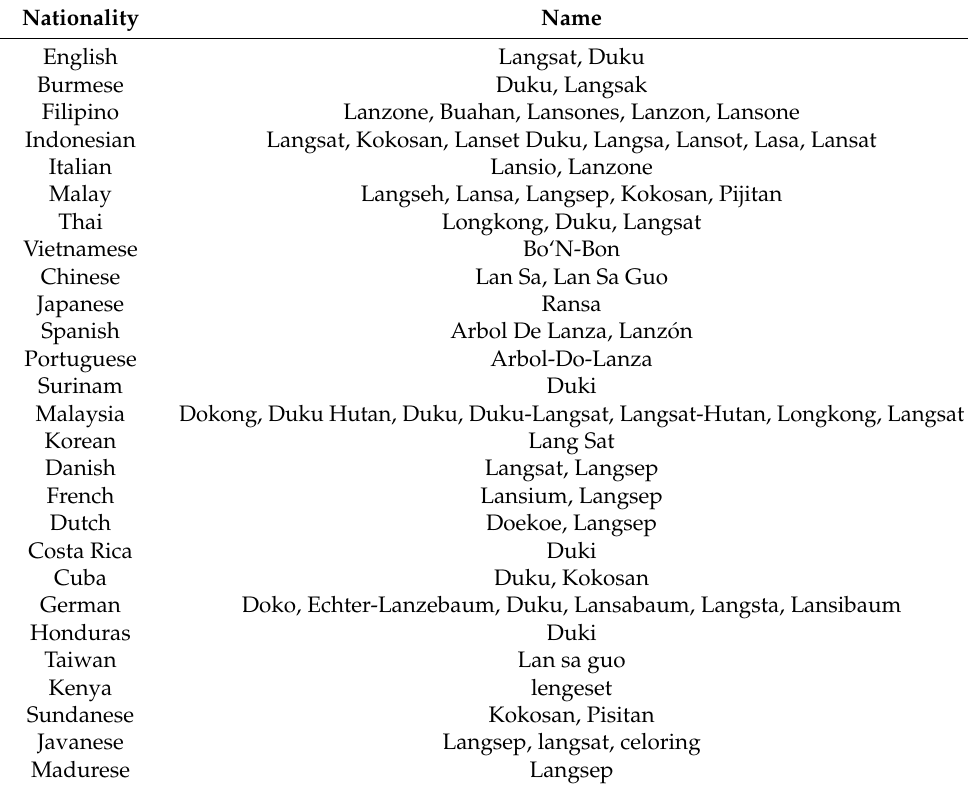
Table 2. Different local names of L. domesticum according to the nationality